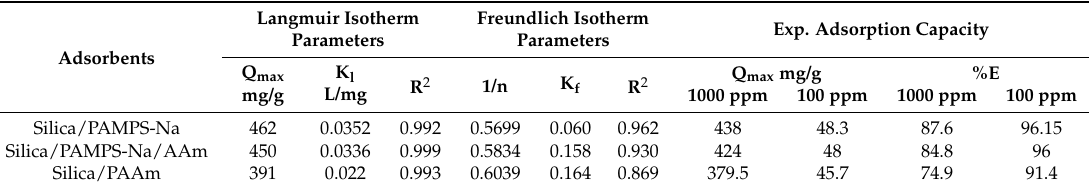
Table 5. Adsorption isotherm parameters for removal of 1000 ppm of MB dye using silica nanogels at 25 ◦ C.